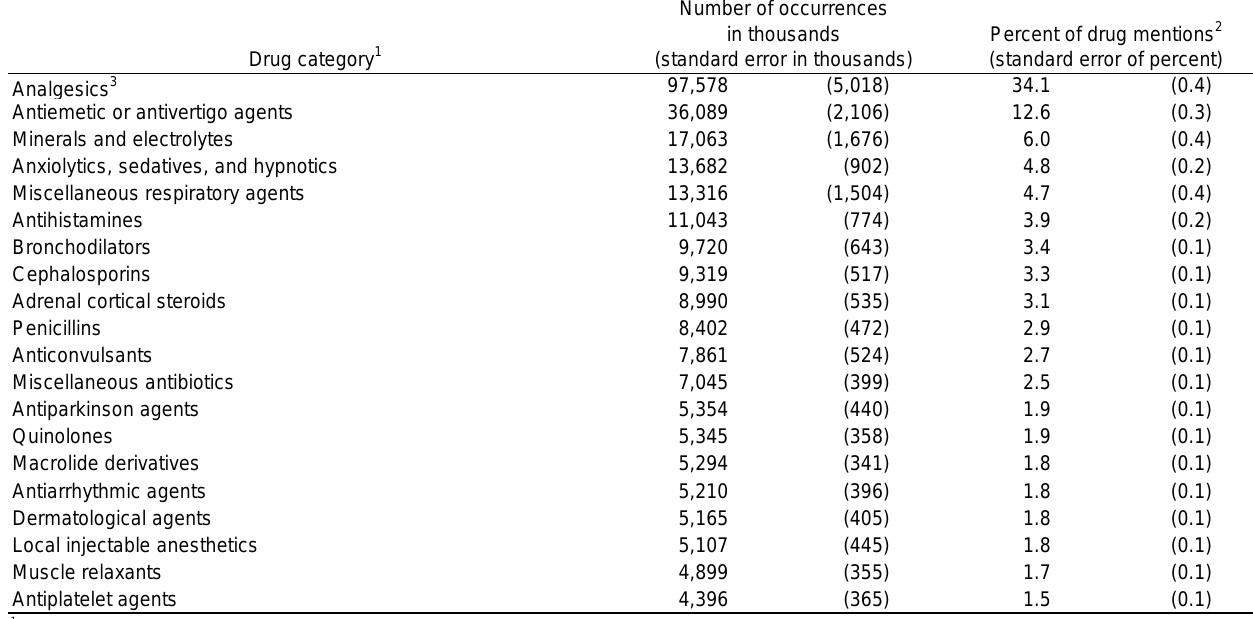
Table 21. Twenty most frequently mentioned drugs by therapeutic drug categories at emergency department visits: United States, 2011